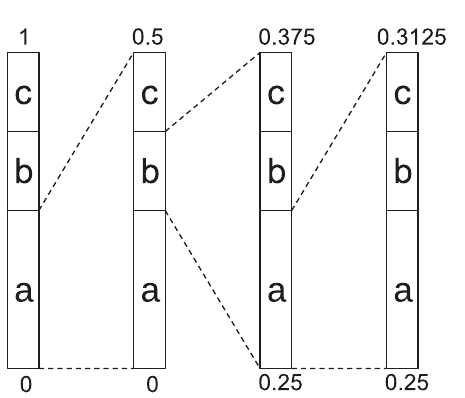
Fig. 6 | Overview of the DNA storage work fl ow using DNA-Aeon: Input data is encoded and packetized using the NOREC4DNA Raptor fountain code, fol- lowedby periodicinsertionofan8-bitCRCchecksum, includinga fi nalCRCto protect the endofthe packet. The packets are thenencoded inparallel using the arithmetic code, using a constraint-free codebook. The channel (right side of the fi gure)representstheDNAsynthesis,storage,andsequencingoftheencodeddata.